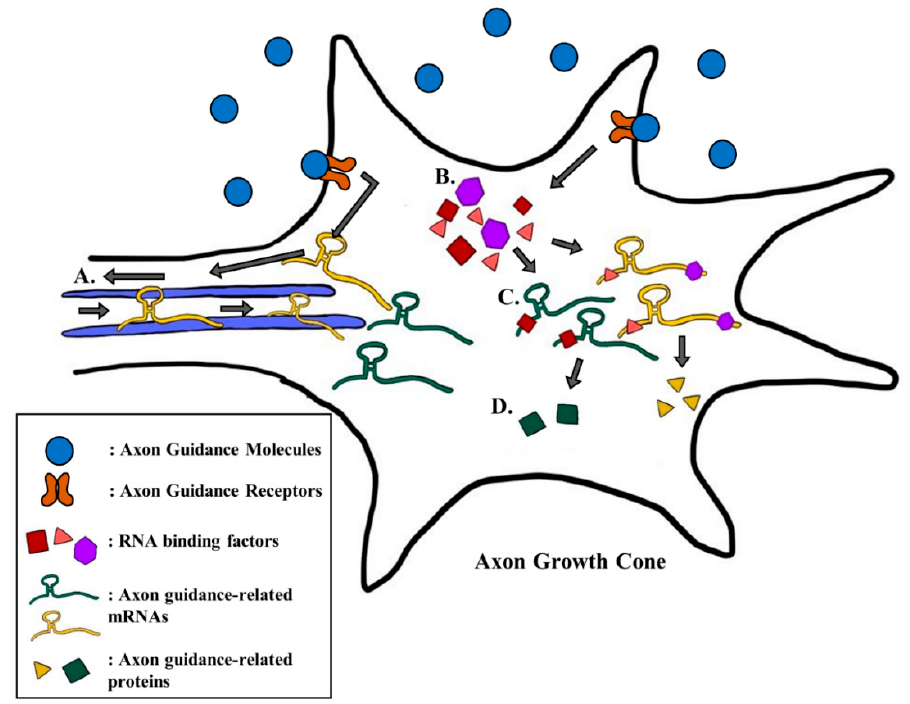
Figure 1. Regulation of local gene expression by axon guidance cues and receptors. The figure summarizes different mechanisms of axon guidance cues and receptor-mediated regulation of local gene expression. (A) The axon guidance cues and receptors can induce the localization of specific mRNAs by regulating the 3 ′ UTR-dependent transport system. (B) The guidance cues and receptor can also affect the local translation of specific mRNAs by increasing the expression of different RNA binding factors. (C) These RNA binding factors, like RNA binding proteins or microRNAs, bind to their target mRNAs and can either enhance or suppress the translational activity of their target mRNAs. (D) The level of axonal protein is, therefore, dependent on the interaction between the mRNAs and different RNA binding factors, which is regulated by the axon guidance cues and receptors. The gray arrows represent the pathway of axon guidance-mediated regulation of gene expression.